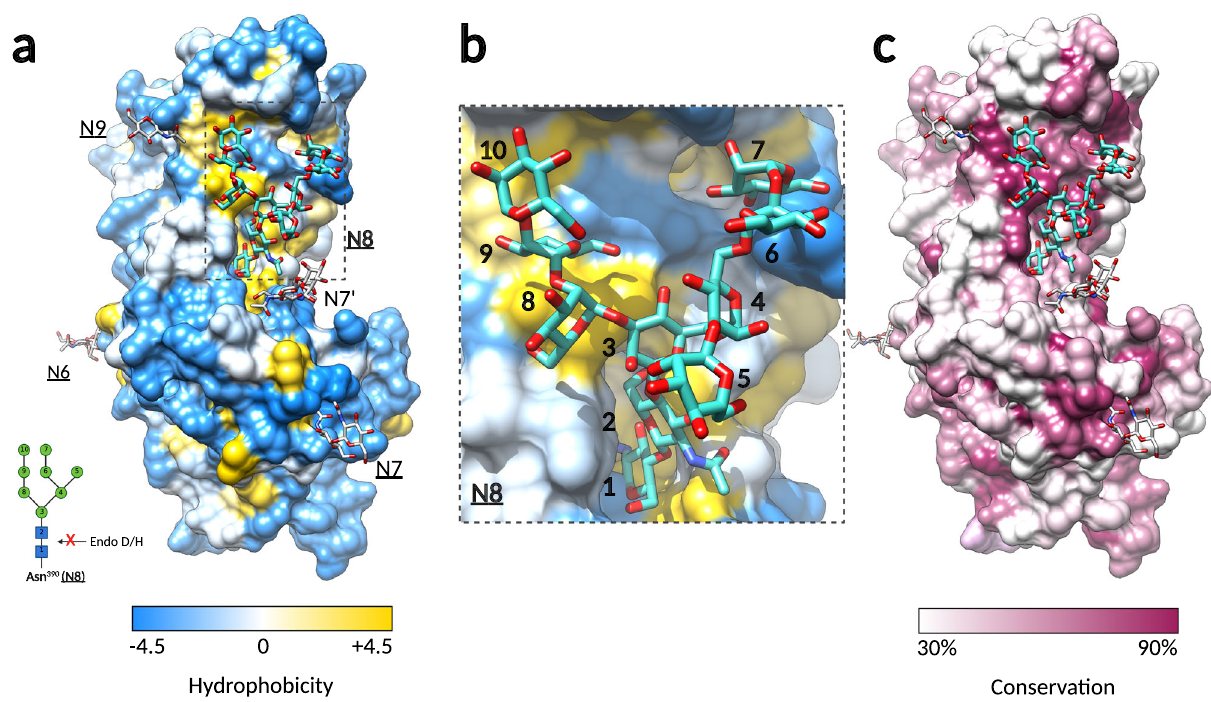
Fig. 3 | The oligosaccharide linked to N390 plays a structural role in the RBD. a Molecular surface representation of the SFV RBD colored by residue hydro- phobicity. Hydrophobicity for each residue was calculated according to the Kyte and Doolittlescale 66 inChimera 29 , withthe gradientcolorkey indicatingthelowest hydrophobicityinblue,tothehighesthydrophobicityinyellow.Thesugarsatsites N6, N7, N7 ’ , and N9 are displayed as white sticks, and the sugar attached to N8 as cyan sticks. The inlet shows the bond cleaved by glycosidases Endo D/H, which is protected in N8. b The N8 sugar attached to N390 covers a hydrophobic region. Magni fi edregionwithinthedashed-linerectangleinpanelaIsshown.TheNAGand